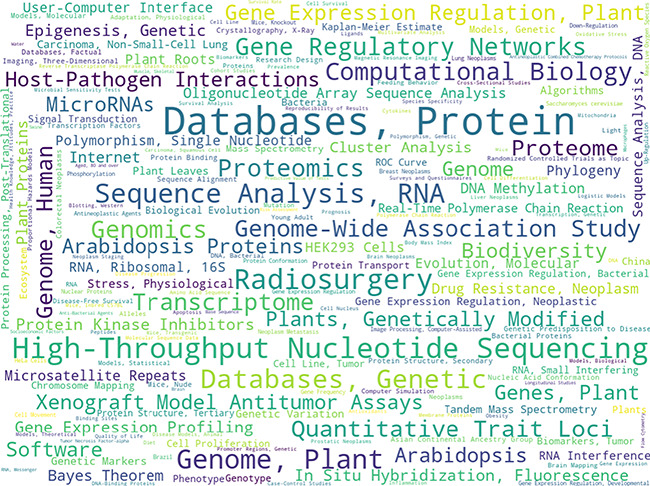
Word cloud of the 250 most frequent MeSH qualifiers from all seed articles normalized by frequencies in the whole PubMed library. In total, unique qualifiers present in the seed article collection (i.e. each seed article with its recommended candidate articles) cover 76% of all unique MeSH qualifiers.